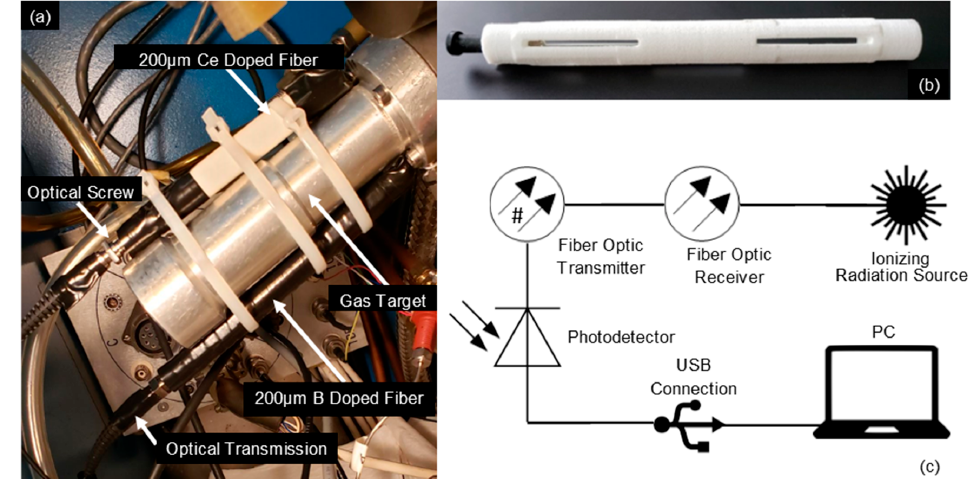
Figure 1. ( a ) 200 µm Ce-doped fiber and 200µm B-doped fiber mounted to the 18 F gas target. ( b ) 200 µm borosilicate fiber in plastic housing without the black tape wrapping to prevent background from ambient light. ( c ) Schematic of the setup.